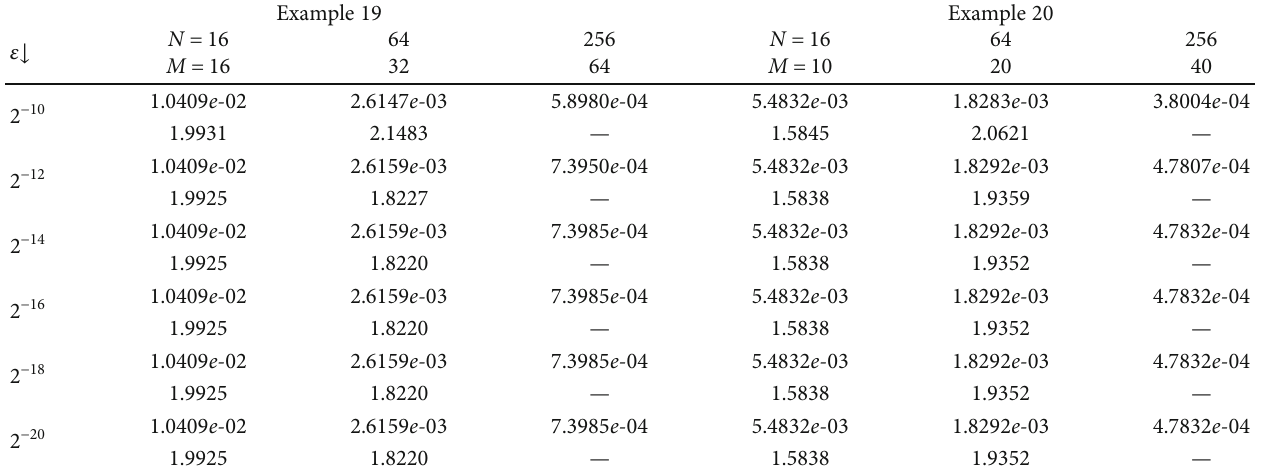
Table 3: Maximum absolute error and rate of convergence of the scheme.